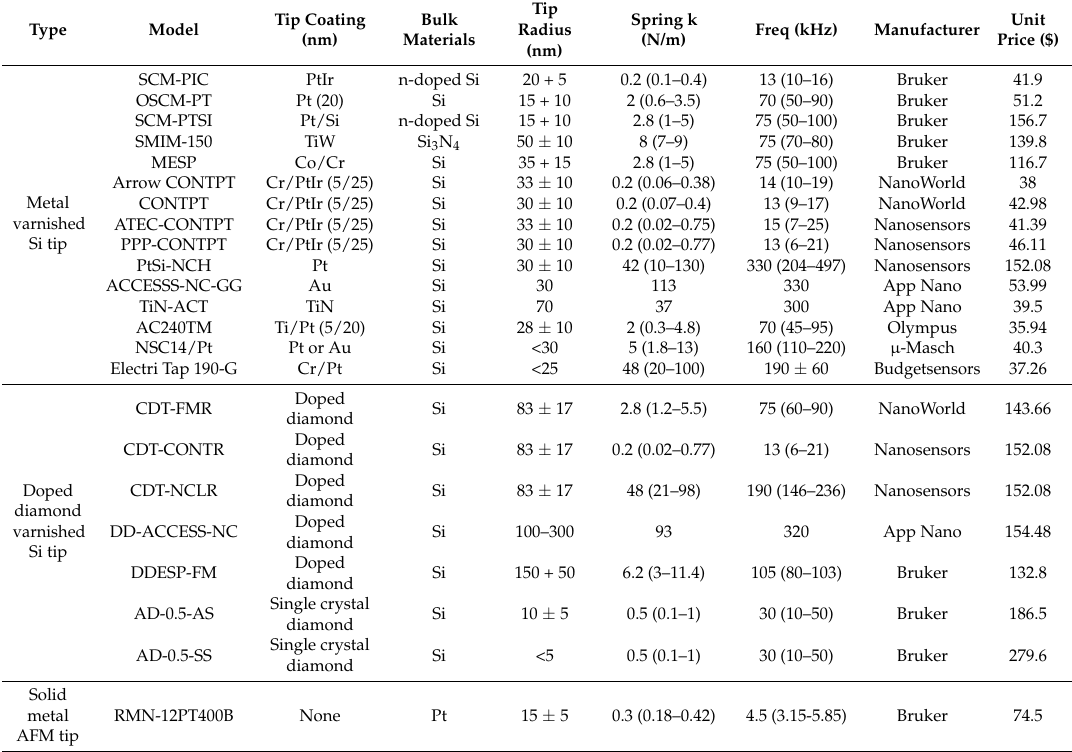
Specifications of the most used commercial conductive nanoprobes from different manufacturers. The prices represent the cost given by the local distributors in